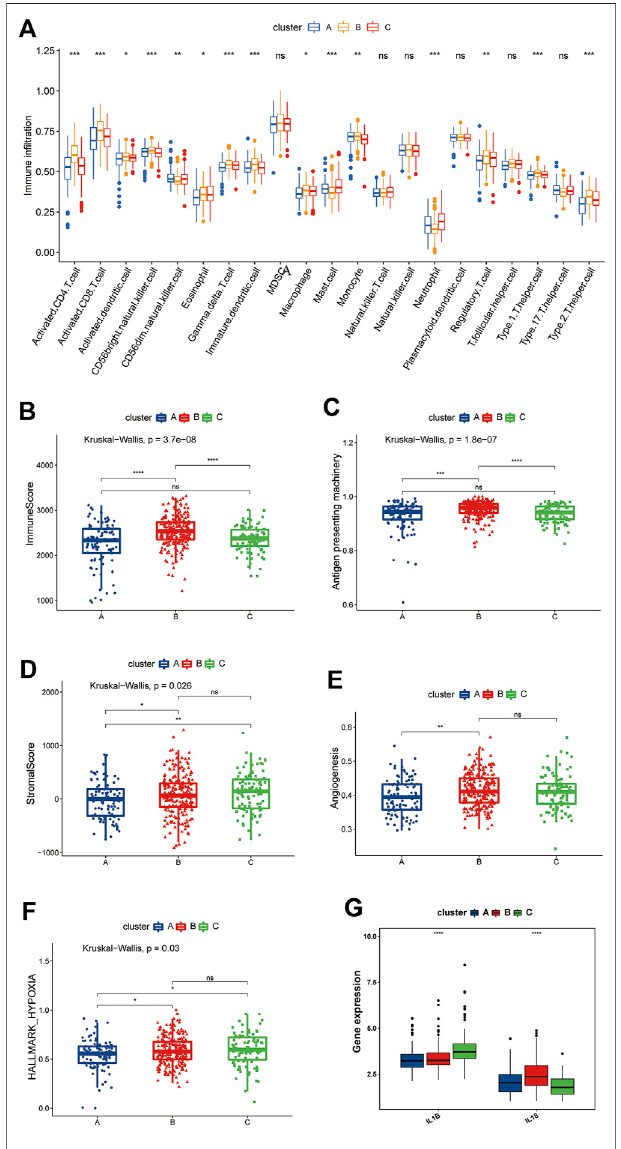
FIGURE 5 | Differences in the TME among the three pyroptosis-related clusters. (A) Differences among the three clusters in the abundance of in fi ltrating immune cells. The blue box, the cluster A; The yellow box, the cluster B; The red box, the cluster C. (B) Differences in ImmuneScore among the pyroptosis-related clusters. (C) Differences in the APM signature score among the pyroptosis-related clusters. (D) Differences in the stromal score among the pyroptosis-related clusters. (E) Differences in the angiogenesis signature score among the pyroptosis-related clusters. (F) Differences in the hypoxia signature score among the pyroptosis-related clusters. (G) Comparison of the IL-1 β and IL-18 expression among the pyroptosis-related clusters. (B – G) The blue box represents cluster A, the red box represents cluster B, and the green box represents cluster C.